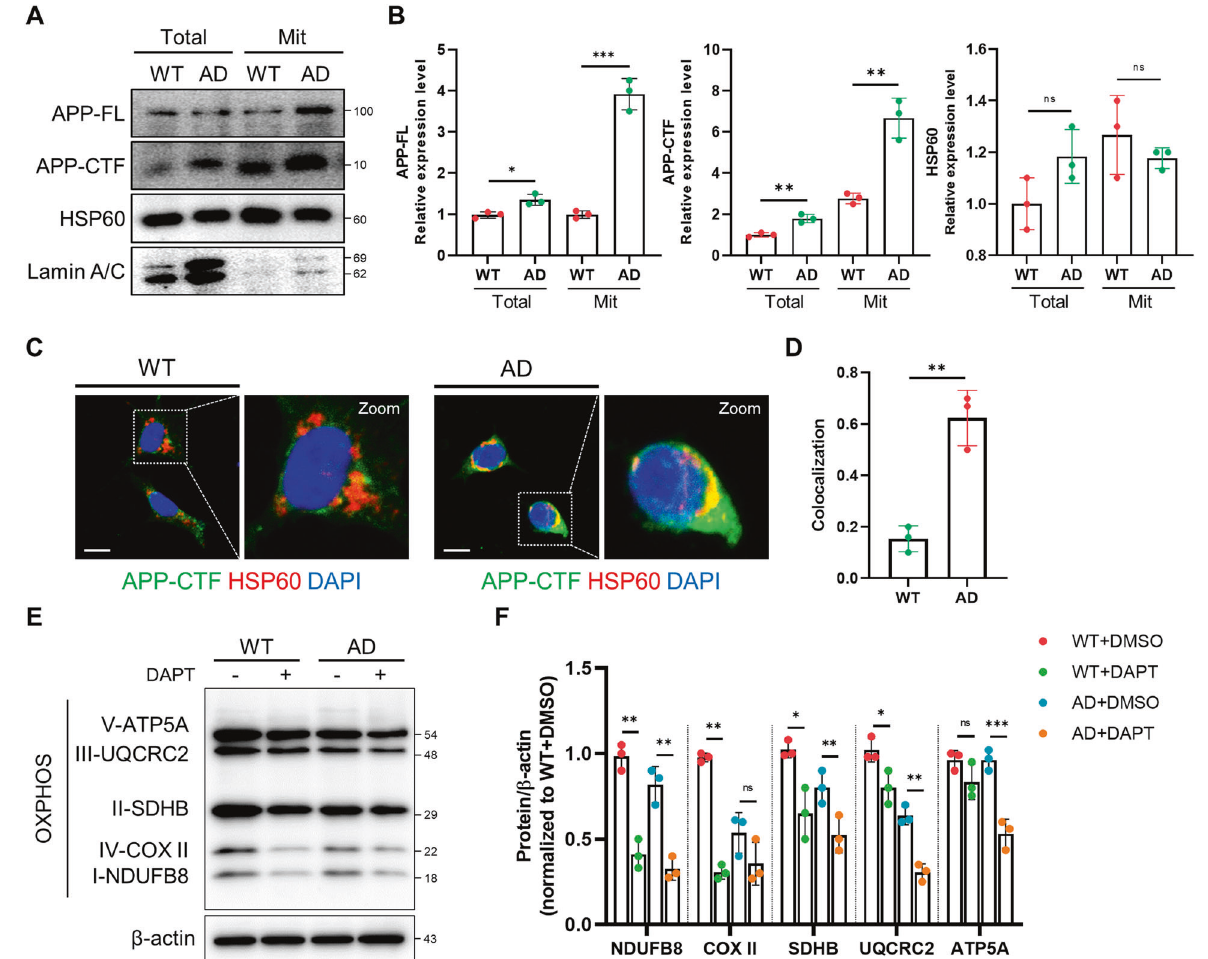
used as loading controls for whole-cell extraction and mitochondrial fractions, respectively. B Quanti fi cation of APP, APP-CTFs, and HSP60 in total extracts and mitochondrial fractions. C Immunostaining of WT- and AD-iNSCs using APP-CTF and HSP60 antibodies. Nuclei were stained with DAPI. Scale bars, 10 µm. D Quanti fi cation of the colocalization area using ImageJ in WT- and AD-iNSCs. E Western blotting of OXPHOS in vehicle- or γ -secretase inhibitor-treated WT- and AD-iNSCs using OXPHOS cocktail antibodies. F Quanti fi cation of the levels of NDUFB8,